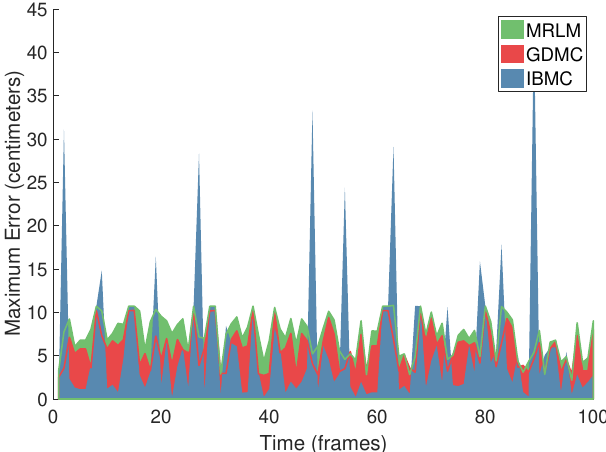
Figure 7. Error over time. We visualize the maximum error per pose produced by each of the three algorithms over a sequence of 100 temporally continuous frames. We observe a very uneven distribution of the error in the time domain, resulting in jitter in rendered sequences.